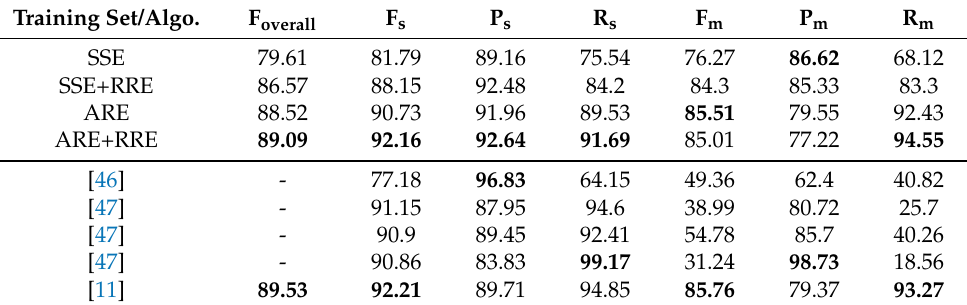
Table 5. This evaluation was conducted on the MIREX competition dataset. The upper half compares our model trained on different training sets. The bottom half shows the previously submitted algorithms (Algo.) to the competition. The results were obtained from the MIREX website. Ref. [11] was the earlier study that adopts our data synthesis procedure. ‘-’ indicates that F overall was not calculated for the submission. The bold values indicate the largest number in each column. Training